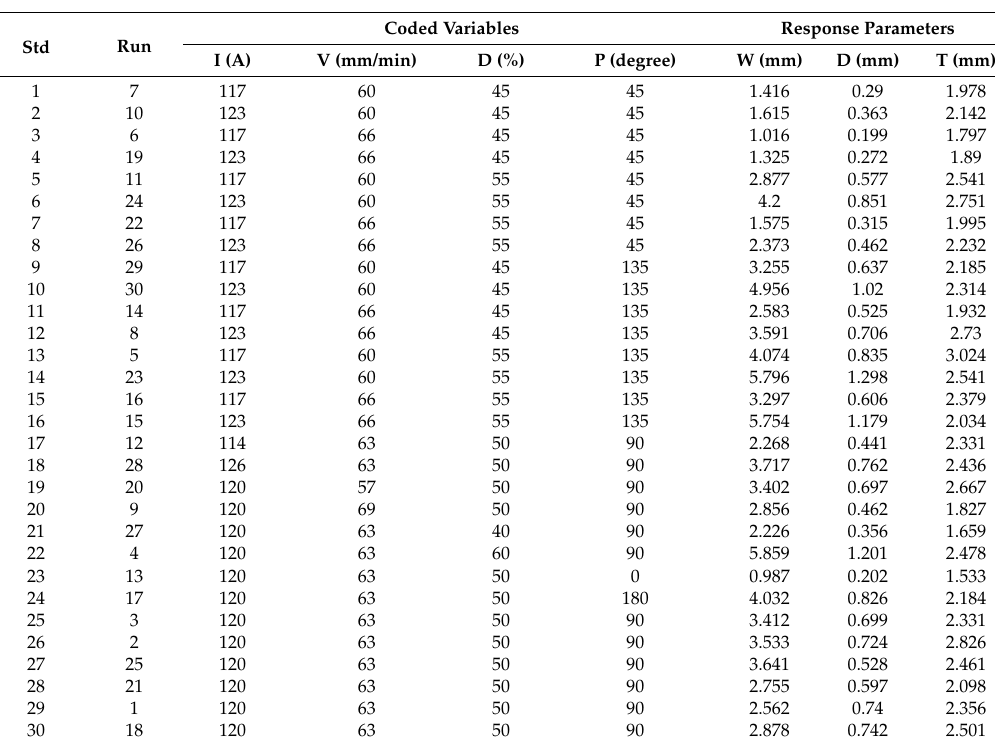
Table 3. Trial design matrix and response of copper–nickel alloy lap